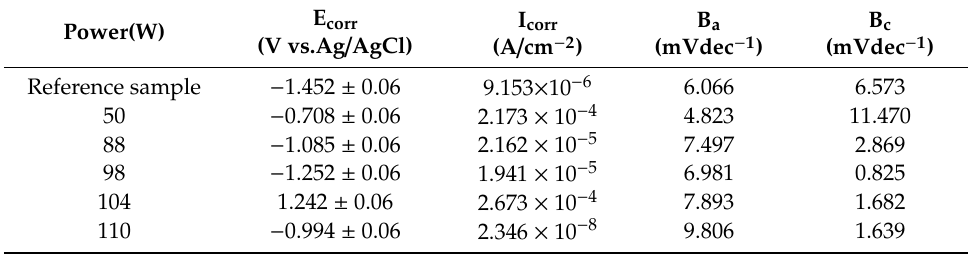
Table 5. Electrochemical corrosion parameters of aluminum alloy after cleaning under di ff erent laser